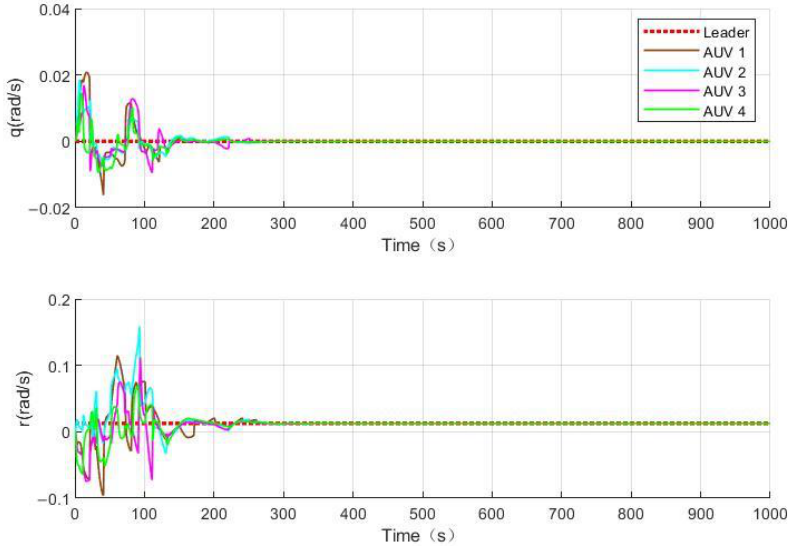
Figure 8. Linear velocity status of the AUV formation.